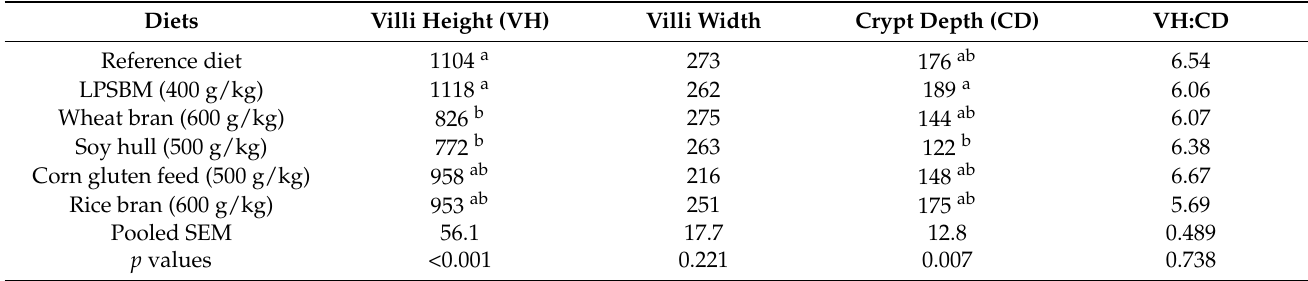
Table 7. Jejunal histomorphology ( µ m) in 21-day-old broilers in response to short-term feeding of high levels of high-protein or high-fiber feedstuffs in a corn–soybean meal reference diet during metabolizable energy assay.